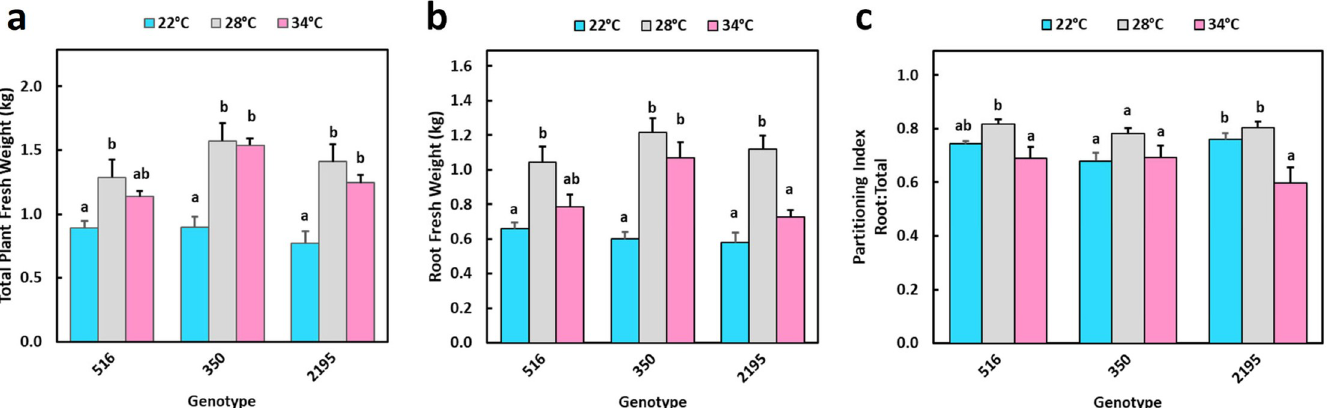
Fig 5. Vegetative growth of three genotypes under controlled temperatures. a) Total plant fresh weight; b) storage root fresh weight; c) partitioning index (storage root fresh weight/total plant fresh weight). Temperature treatments within each genotype which have different lowercase letters are significantly (p � 0.05) different using Tukey’s HSD test. Comparisons and letter assignments were based on estimated marginal means (EMMs, least-squares means), as appropriate for statistical comparisons; arithmetic means and SEMs are plotted.